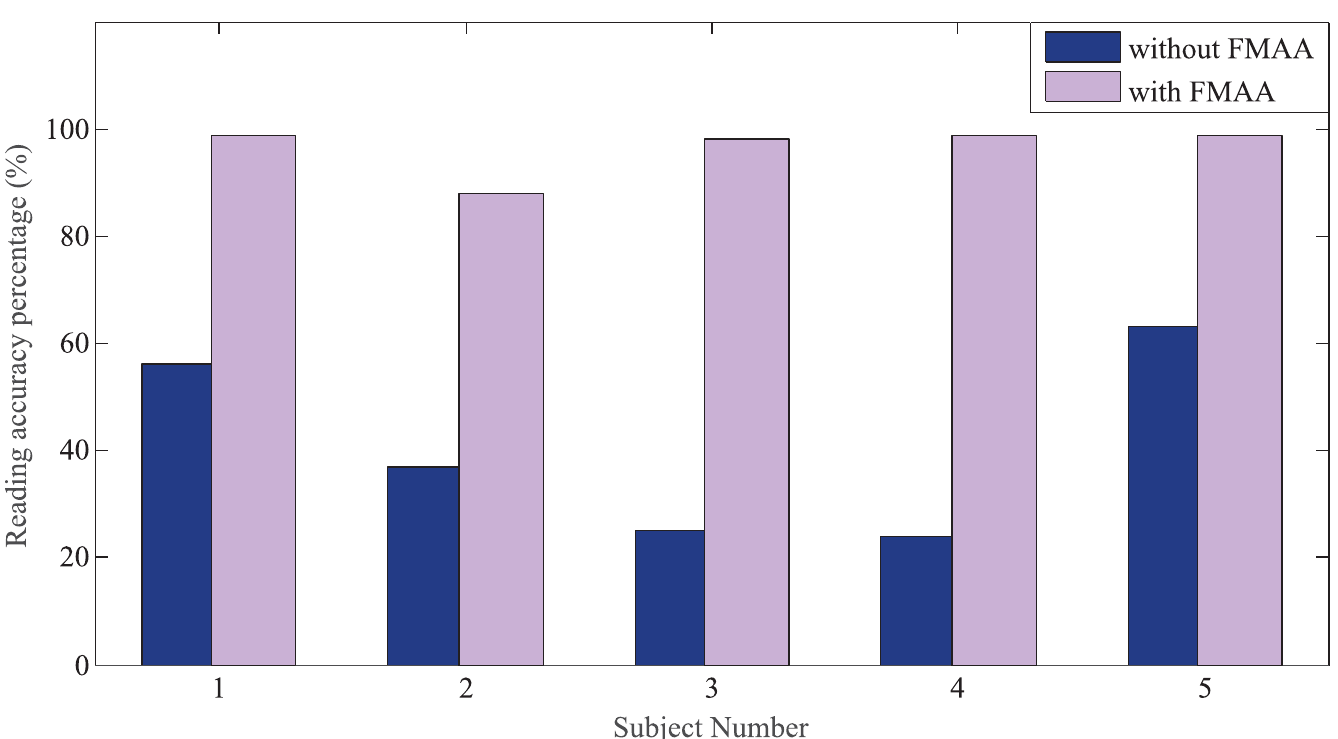
Fig 11. Braille reading accuracy in different experimental conditions. Percentages shown in the figure are calculated by dividing the number of accurately read words by the total number of words in each experimental condition. Accurate reading is assessed based on subject ’ s reading out